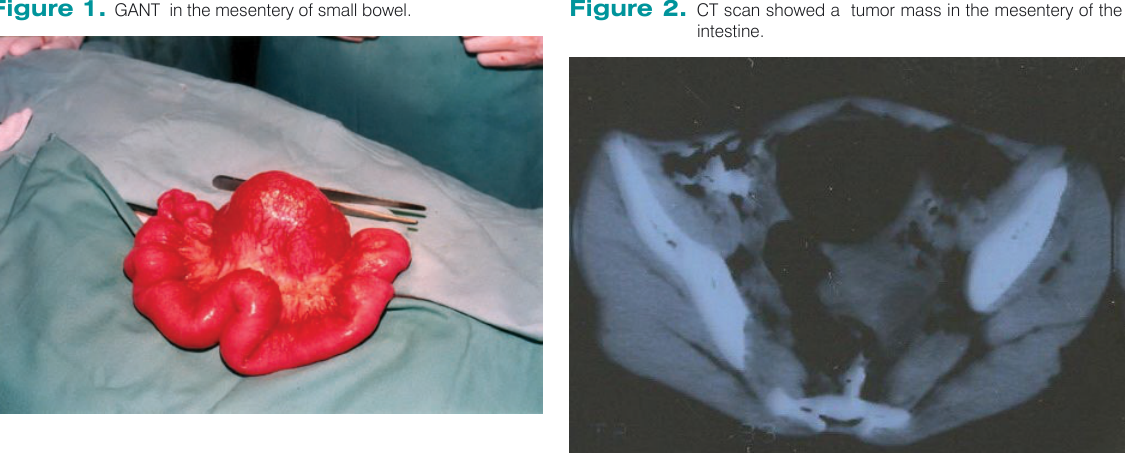
Figure 3. Abdominal ultrasound revealed a large, nonhomogeneous solid mass with multiple cysts in the left paraovarian space.